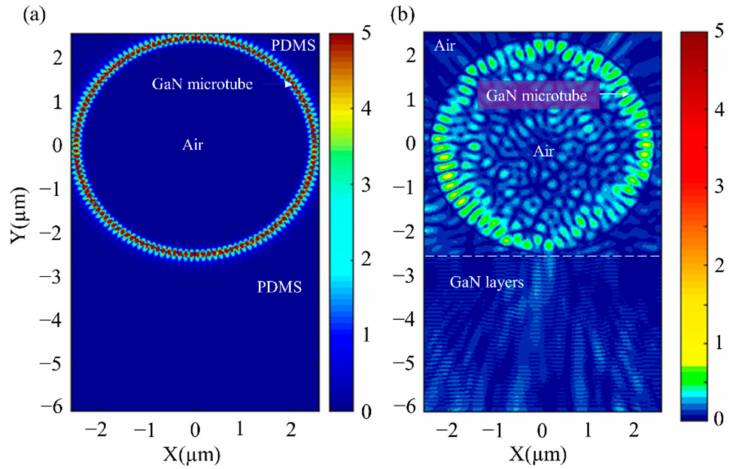
Figure 4. ( a ) Electrical field distribution inside the microtube cavity embedded in a flexible substrate. ( b ) Electrical field distribution inside the microtube cavity with GaN